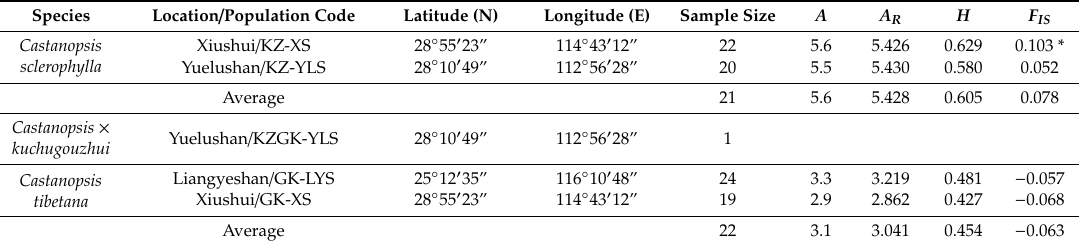
Table 1. Location, sample size, and genetic diversity of the investigated